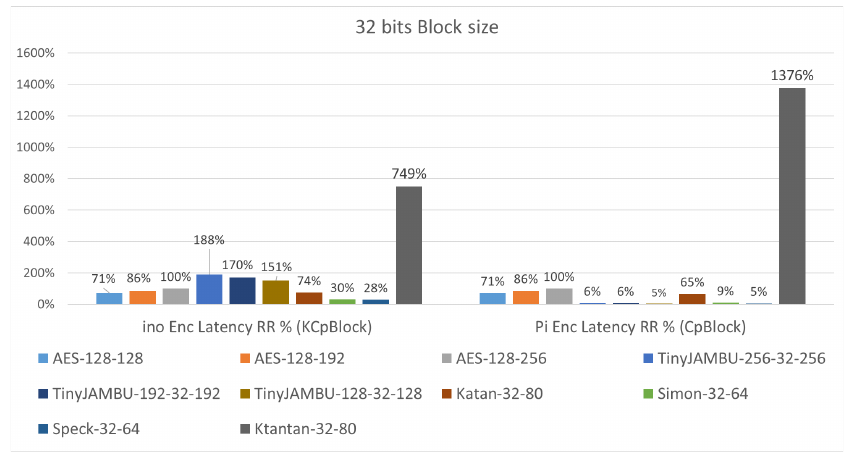
Figure 22. Group of 32-bits block size algorithms measuring ENC speed latency with respec to RR% in UNO versus Pi.